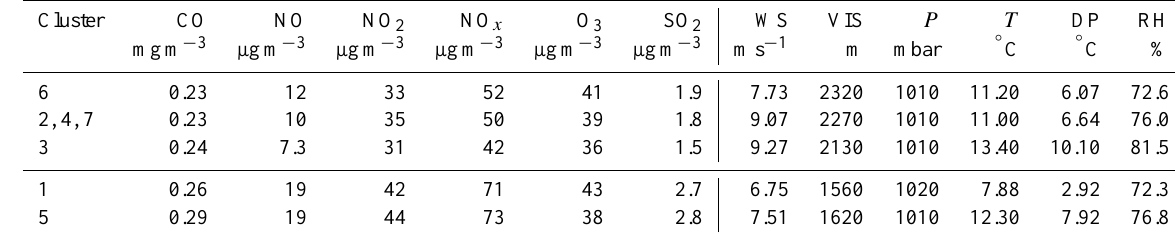
Table 4. Average gas-phase pollutant concentrations and meteorological variables measured for each cluster of trajectories. Cluster